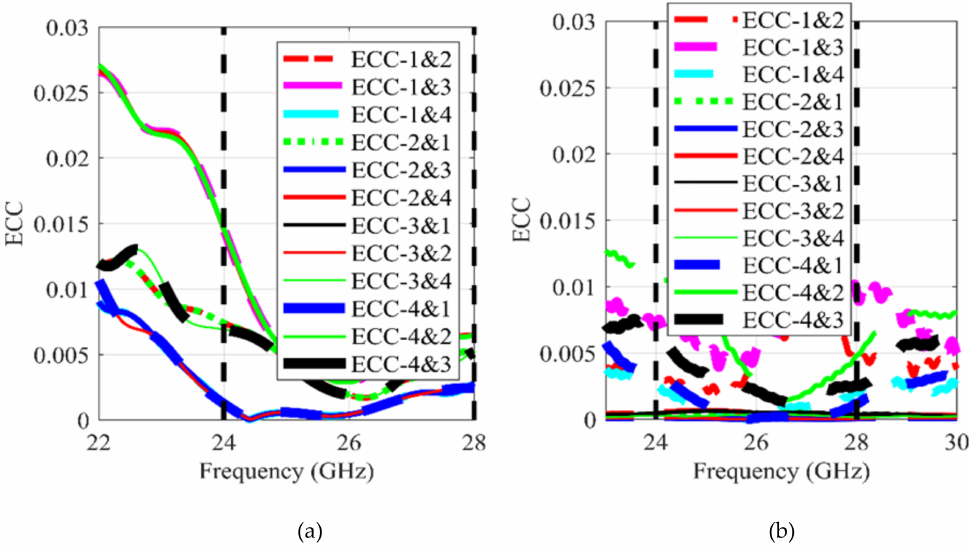
Figure 17. The measured and simulated ECC for mmWave MIMO configuration: ( a ) simulated ECC; ( b ) measured